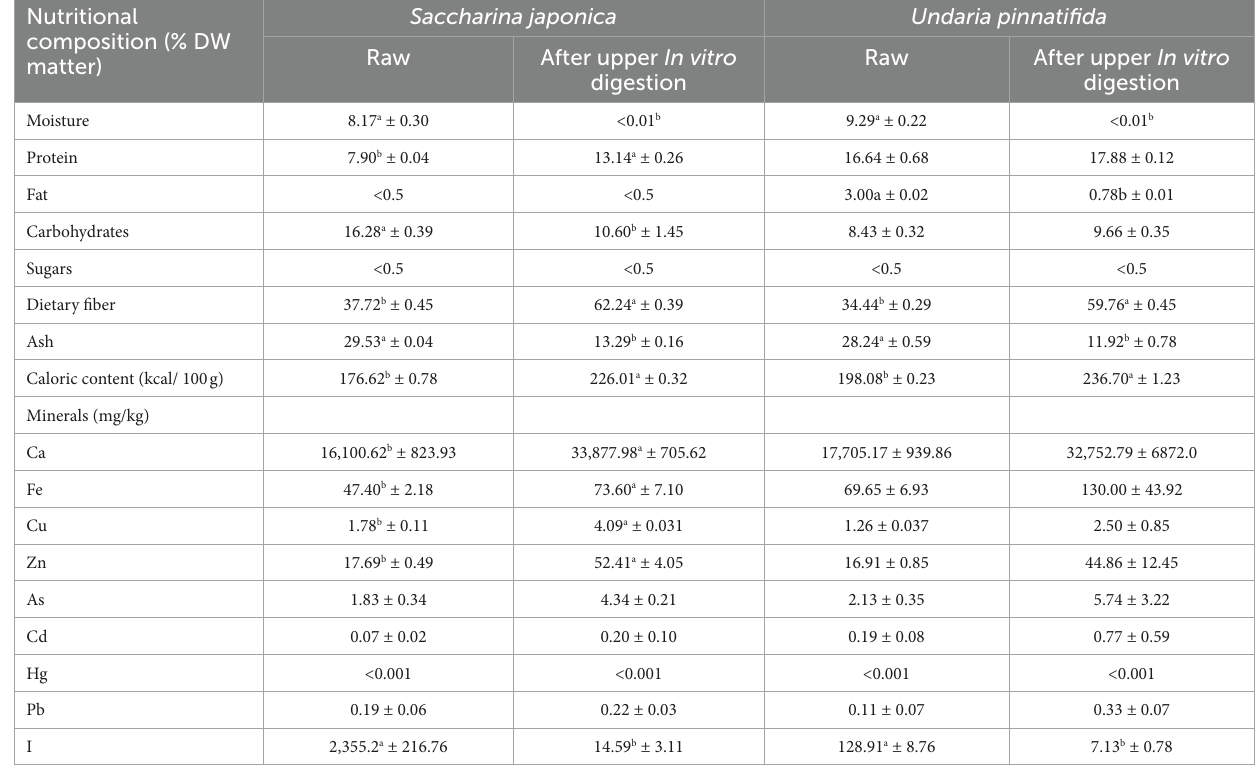
TABLE 1 Comparison of the nutritional composition (g/100 g) and mineral content (mg/kg) of kombu ( Saccharina japonica ) and wakame ( Undaria pinnatifida ) raw and after in vitro upper intestinal digestion. Nutritional composition (%